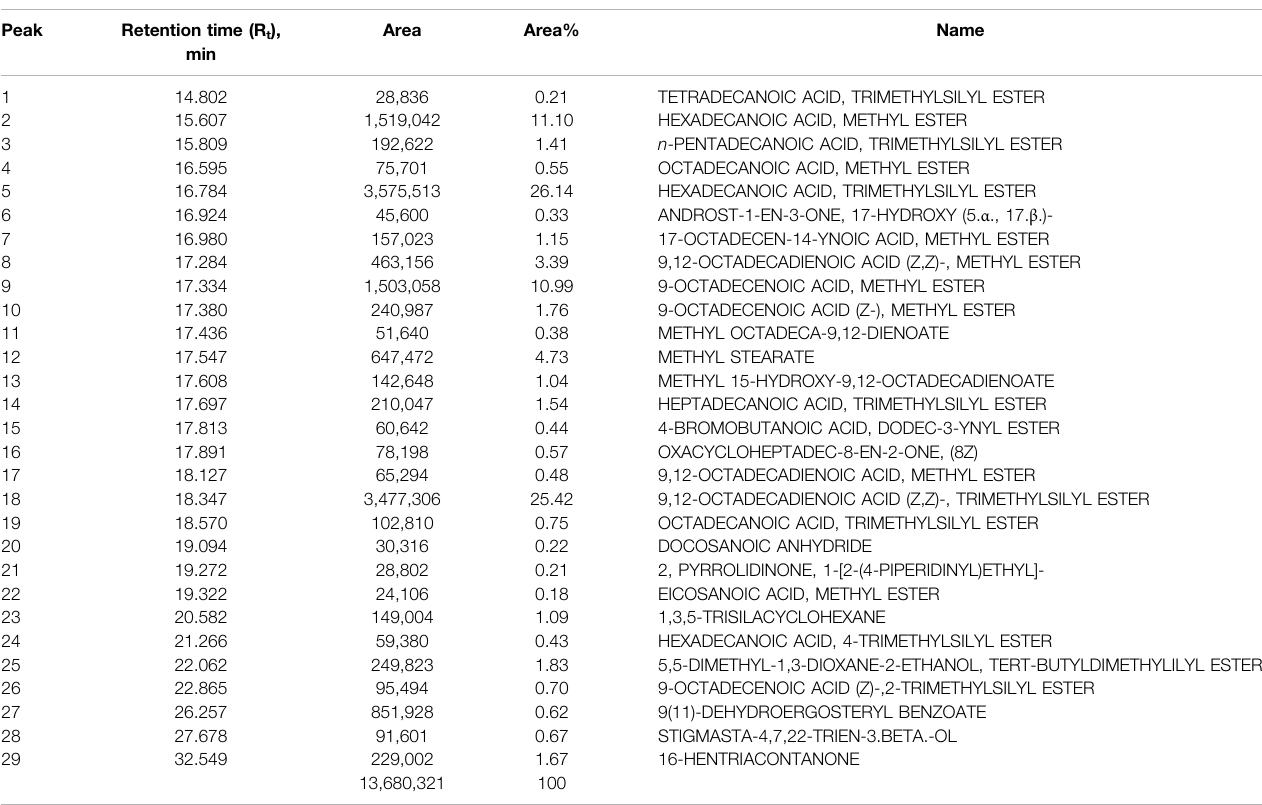
The retention times, peak areas and area percentages are